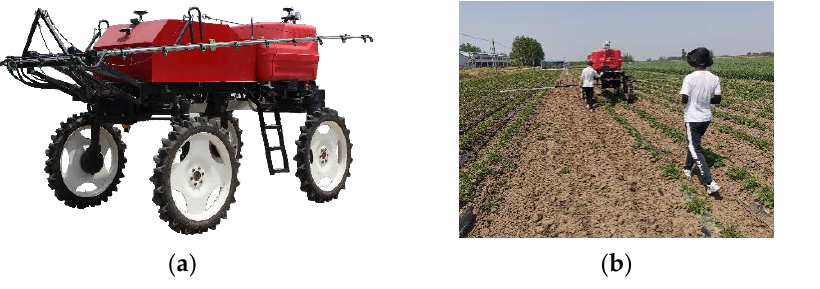
Figure 2. Data Collection: ( a ) acquisition platform; ( b ) simulated operation of remote-control sprayer; ( c ) acquired images.